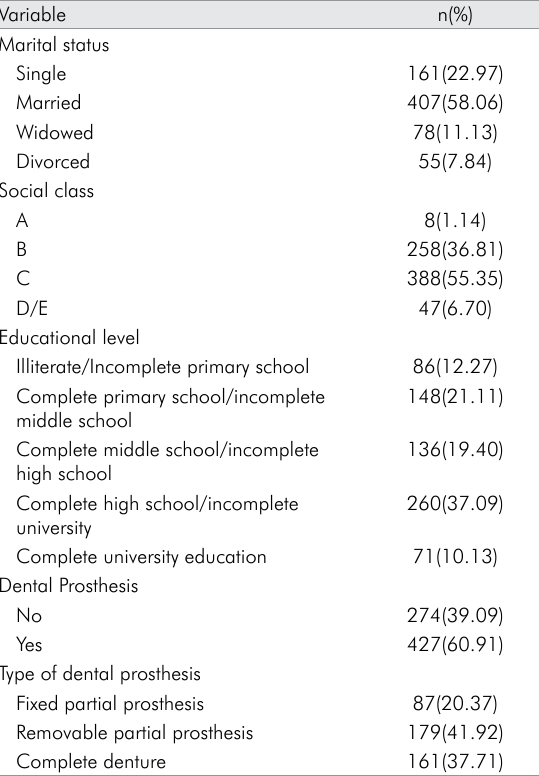
Table 1. Distribution [n(%)] of participants in regard to sociodemo- graphic and clinical characteristics. Araraquara - SP / Brazil, 2011.